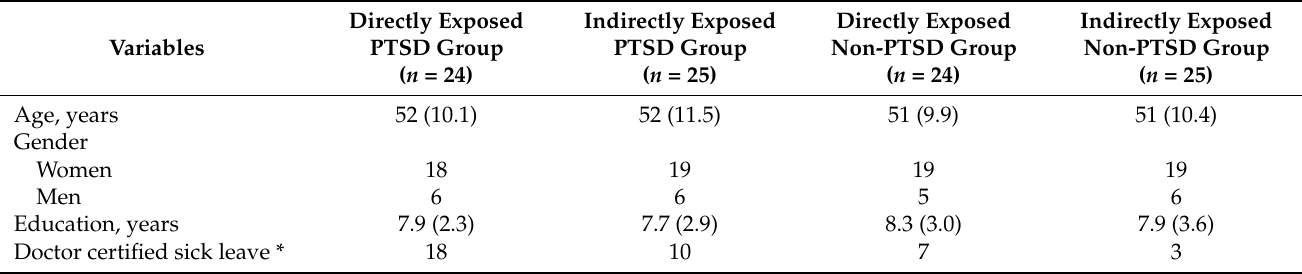
Table 1. Characteristics of the participants in groups of exposure and